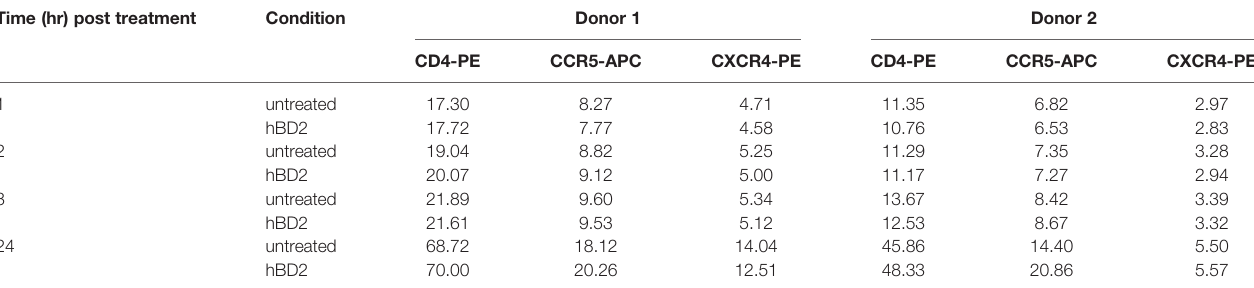
TABLE 1 | Median Fluorescence Intensity (MFI) values for surface receptor expression on MDM. Time (hr) post treatment